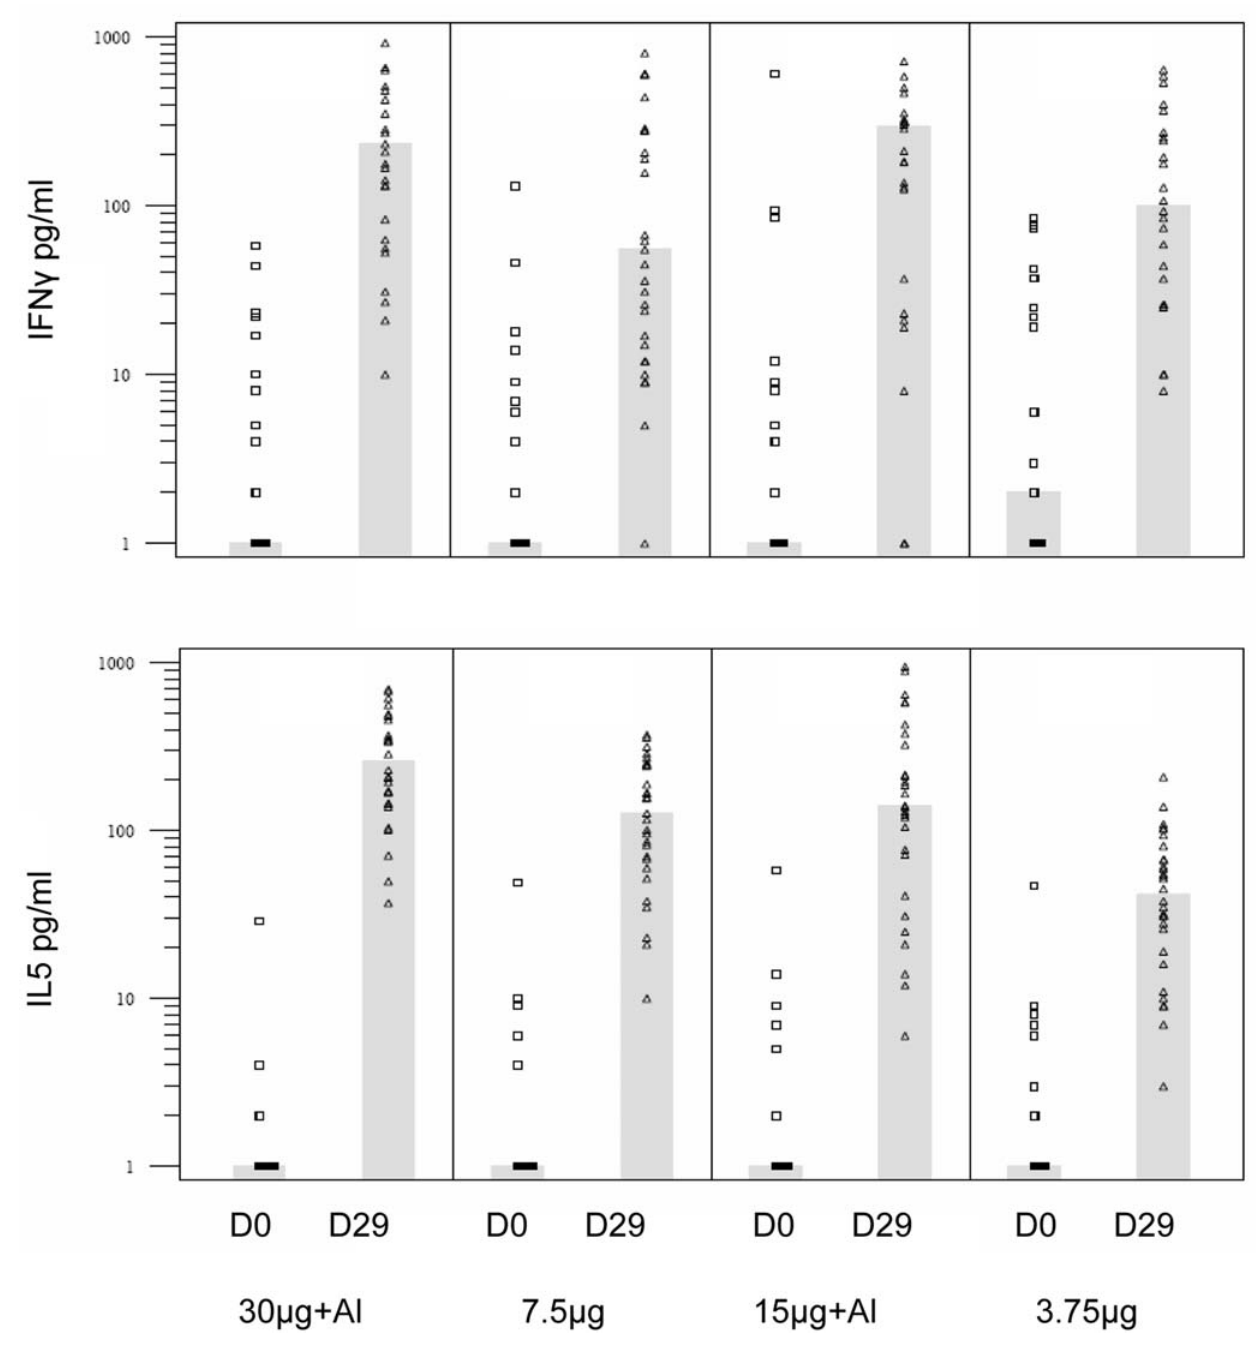
Figure 2. Levels of IFN c and IL5 secreted after in vitro re-stimulation with recombinant H5 haemagglutinin by cells obtained before and eight days after two injections, 21 days apart, of adjuvanted or non-adjuvanted H5N1 vaccine in groups of children aged 6–35 months. Symbols represent results from individual samples, bars indicate the median level.